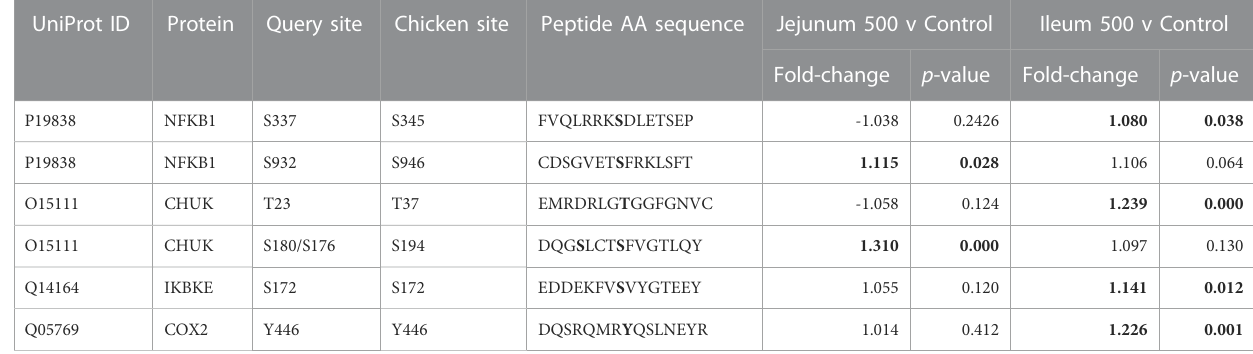
TABLE 8 NF κ B and Related proteins ’ phosphorylation events. Here, the kinome peptide array results are shown. Jejunum 500 and ileum 500 were compared to their respective control tissues. Phosphorylation events represented in this table show signi fi cant ( p -value < 0.05) for sites as described above. Signi fi cant values are highlighted in